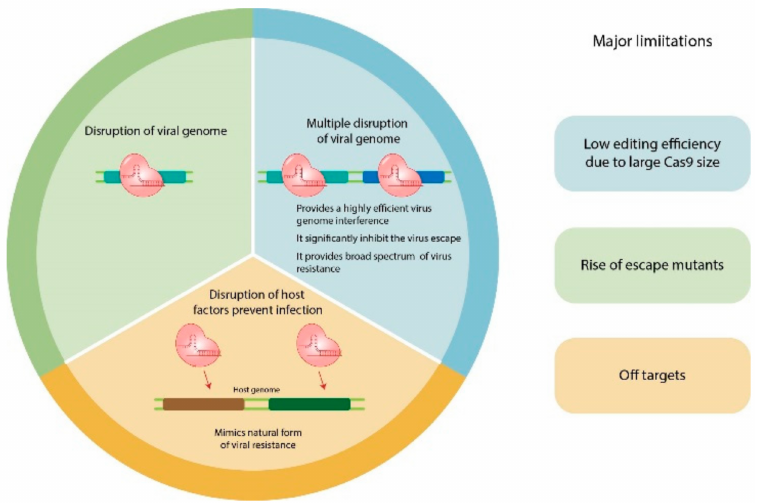
Figure 2. Overview of strategies to combat plant viruses using the CRISPR system. There are three general strategies, and they are discussed in this review to target viral genomes in infected cells. The top left panel displays the directing of genome of DNA or RNA viruses using single sgRNAs by which essential viral genes can be disrupted or the viral genome can be fragmented. The top right panel describes strategies that can be used to target multiple genes of the same or different virus. The lower panel displays the potential to target host factors that are essential for viral propagation and